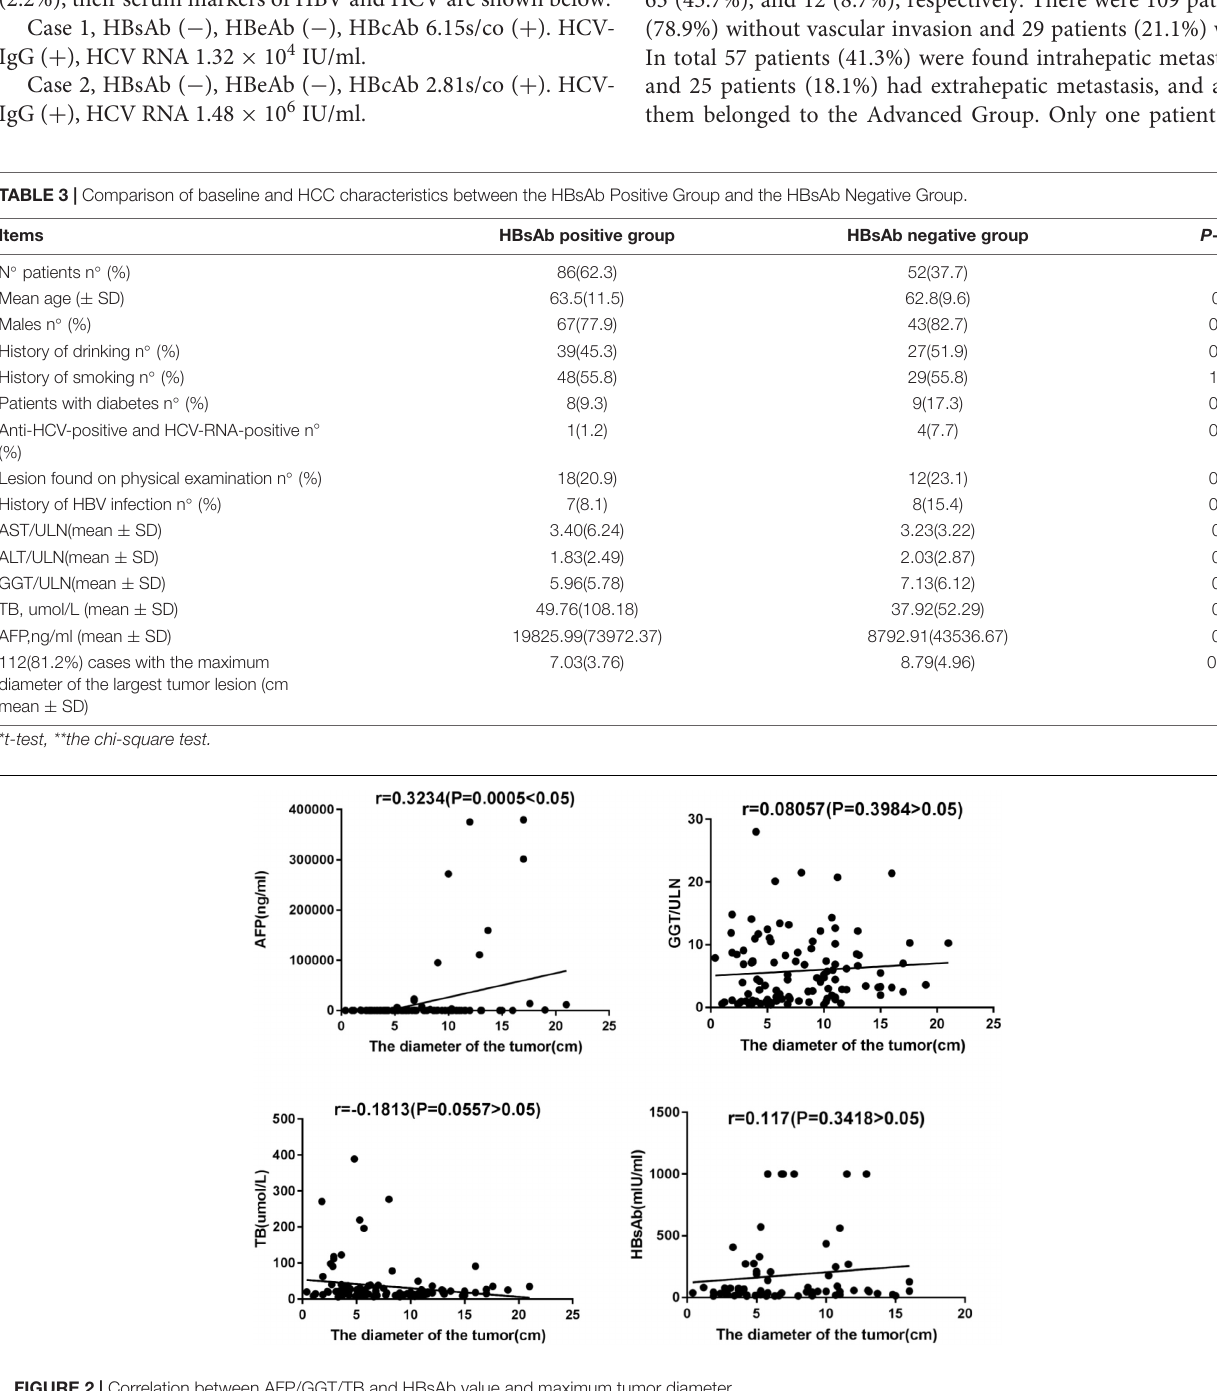
Frontiers in Microbiology |